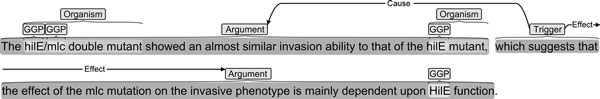
Causal relation in BioCause. Causal relation as annotated in the BioCause corpus, with marked trigger and its two arguments, as well as named entities.